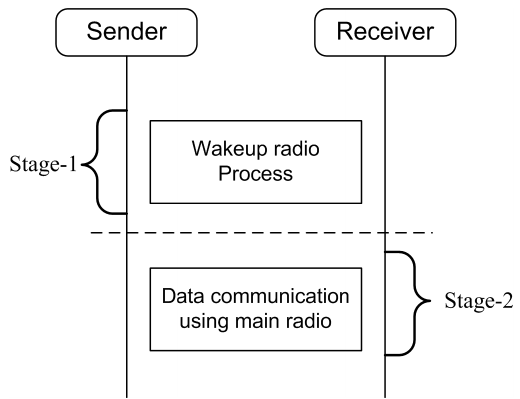
Figure 8. Communication process.